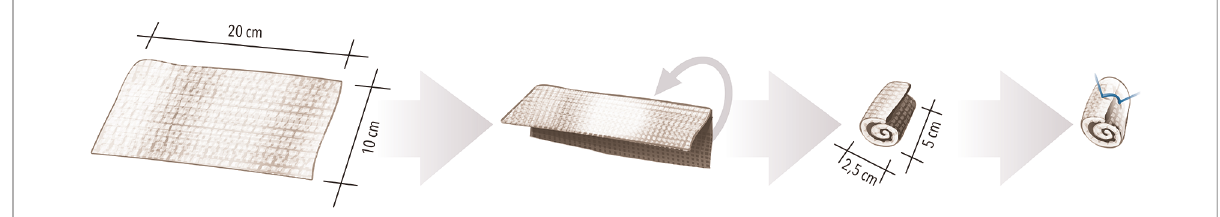
FIGURE 2 Schematic presentation of the bolster, made from surgicel that was manually folded, wrapped and rolled into compact bundle and latter secured with a suture to maintain the